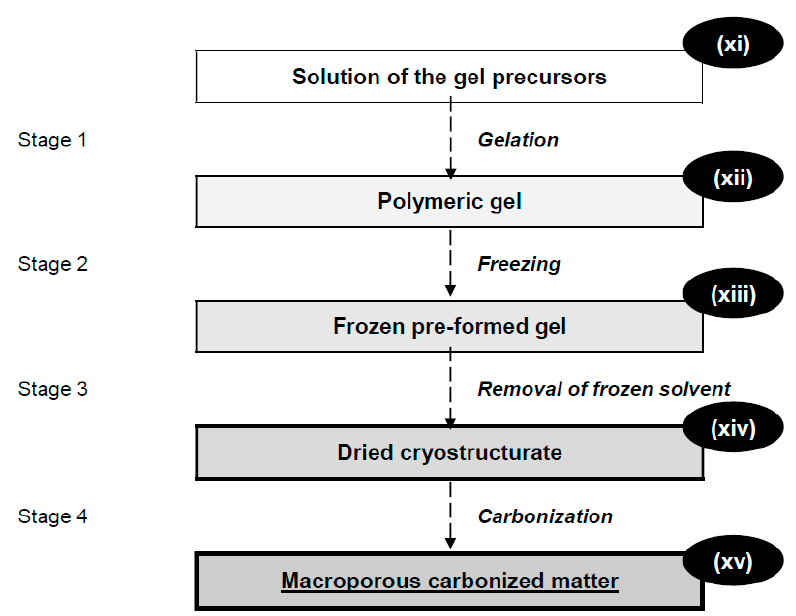
Figure 3. The scheme of the preparation of macroporous carbonized matrices.